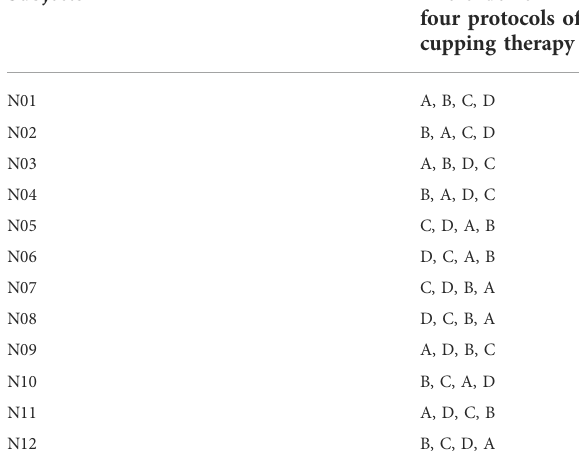
TABLE 1 The counterbalanced order of four cupping therapy protocols used in this study, including − 225 mmHg × 5